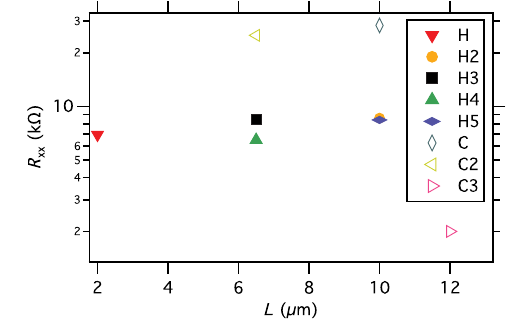
FIG. 6. Four-terminal longitudinal resistance of type-C and type-H devices with various channel lengths, and fixed width of 10 nm at T ¼ 500 mK